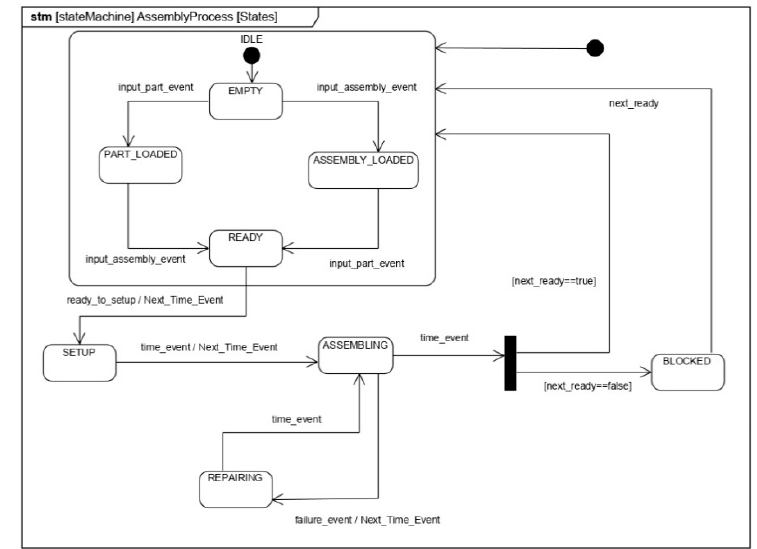
Figure 5. State machine diagram for AssemblyProcess block.